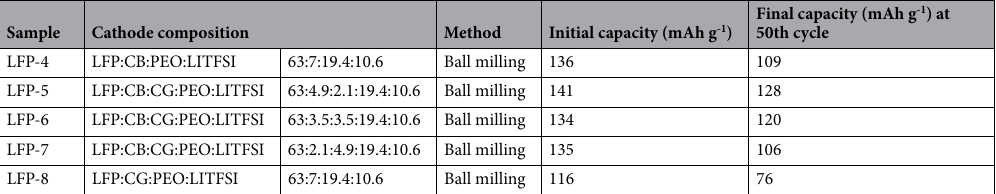
Table 3. Variation of conductive additives keeping EO:Li = 12:1. The batteries were tested at 1C at 70 °C for 50 cycles using Li/SPNE/LFP configuration.